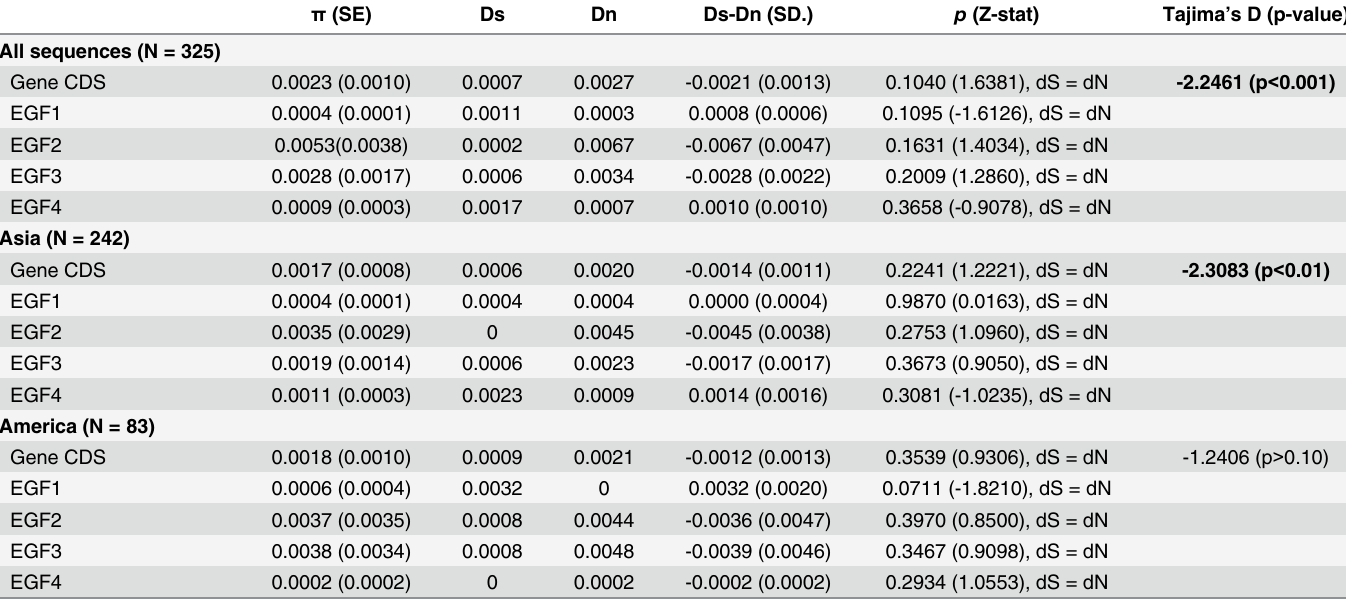
Table 2. Pvs25 worldwide polymorphism by gene CDS and